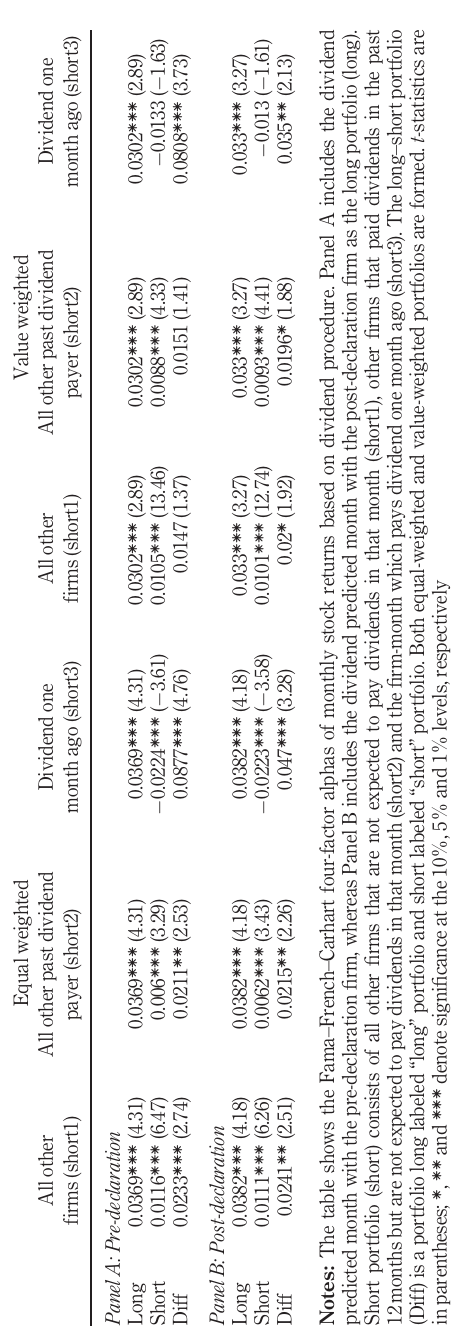
Table 10. Pre-declaration